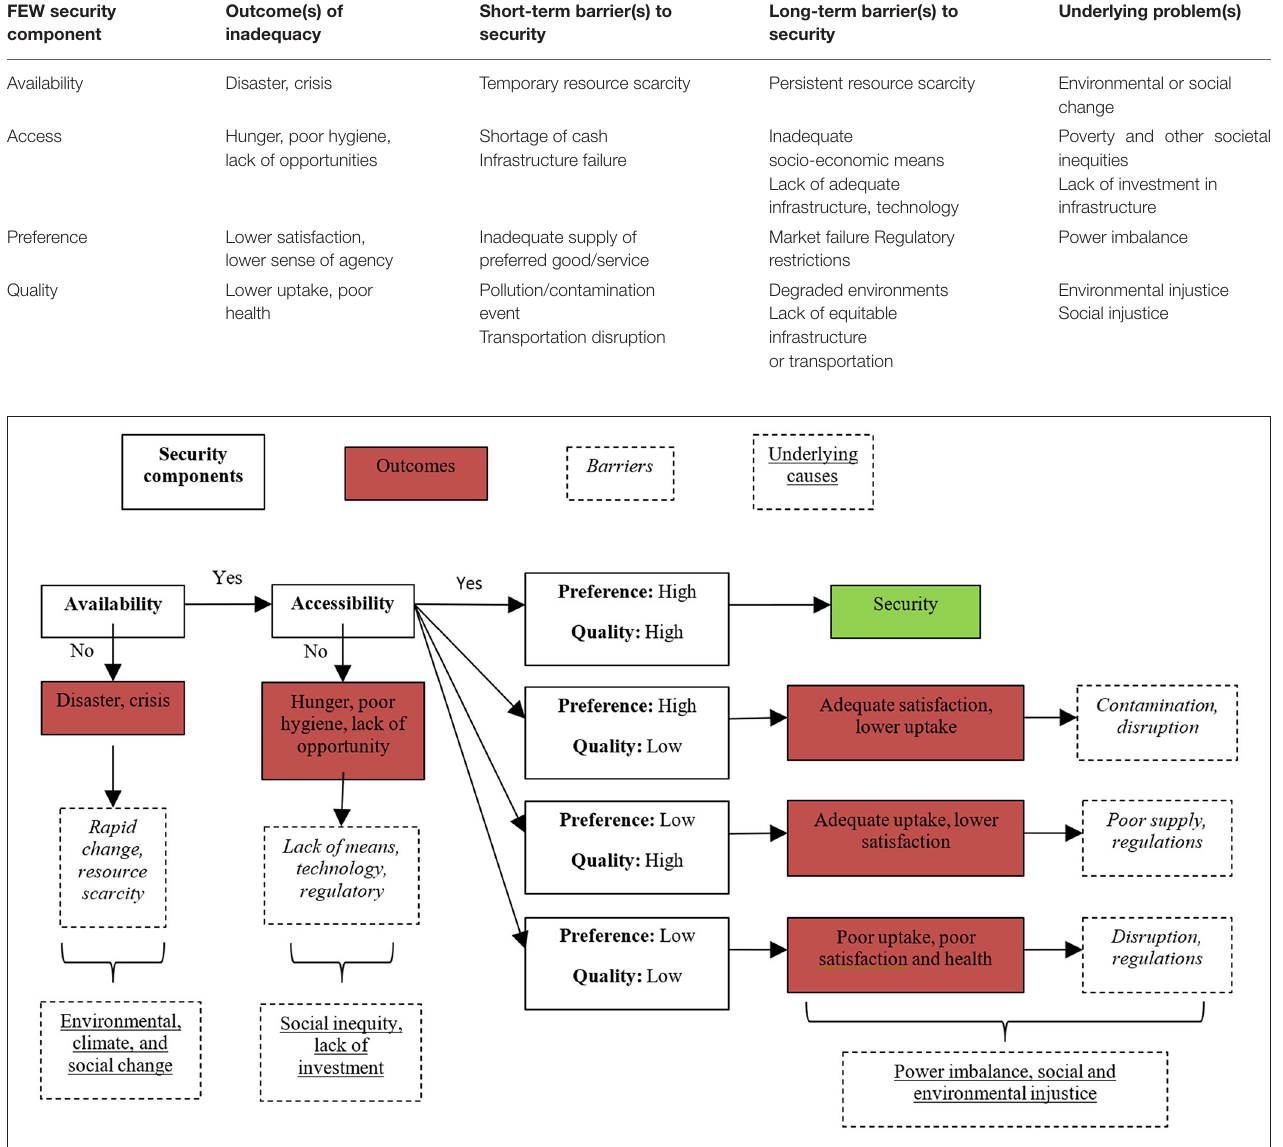
FIGURE 1 | Flow chart of security components and outcomes, indicating examples of the barriers and underlying causes that lead to the outcomes. If the resource is unavailable, accessibility is irrelevant. If a resource is inaccessible, preference and quality are irrelevant. Preference and quality function in parallel, and adequacy is required in both to achieve